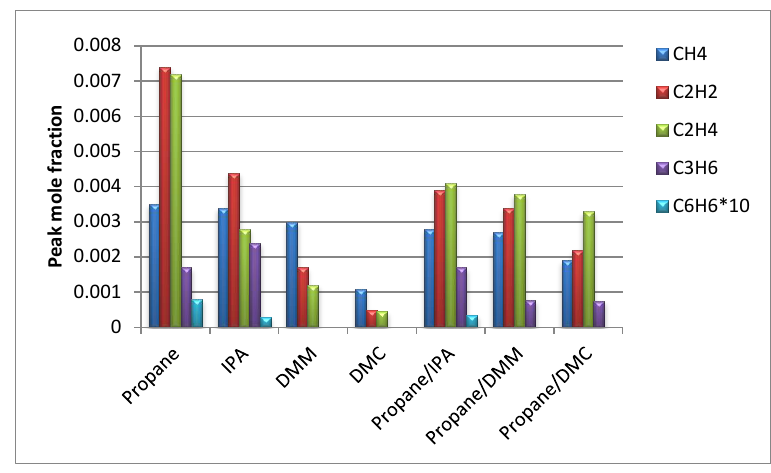
Figure 10. Peak mole fractions of CH 4 , C 2 H 2 , C 2 H 4 , C 3 H 6 , and C 6 H 6 for propane, IPA, DMM, DMC, propane/IPA, propane/DMM, and propane/DMC modified from